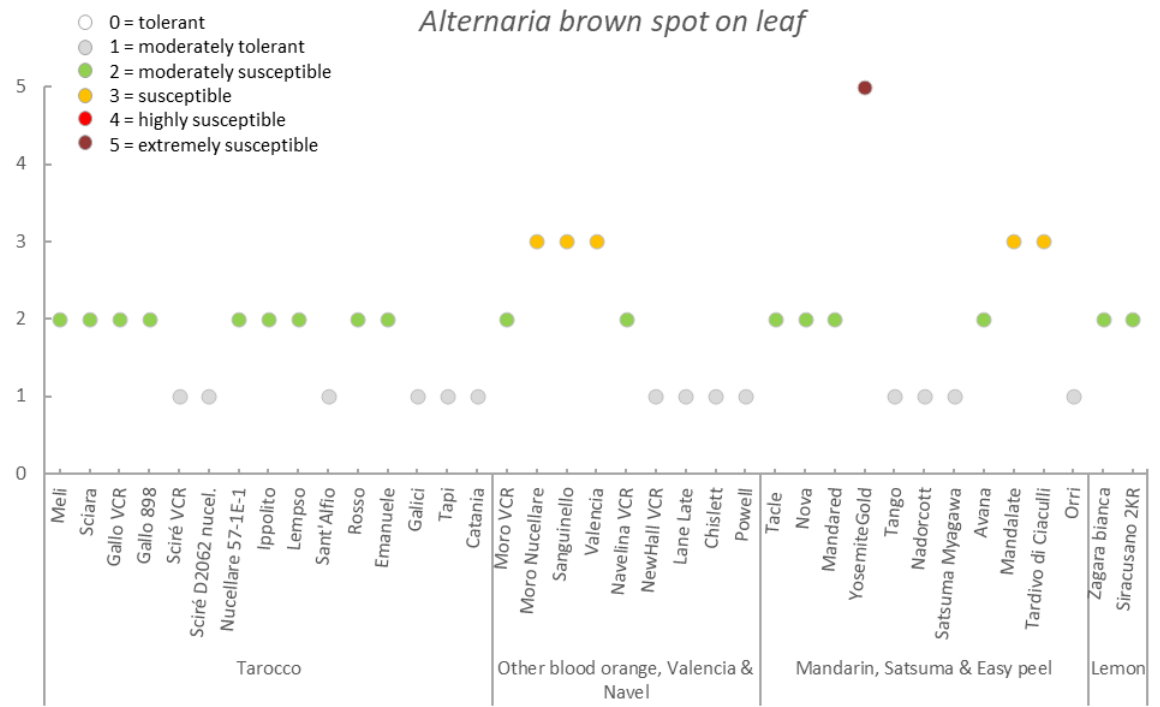
Figure 9. Maximum potential infection risk of Alternaria brown spot on leaf recorded on detected Citrus germplasm. Data obtained from several Sicilian citrus production areas (from 1-to-20) within Citrus groups surveyed for three periods intercepting an eleven-year survey.